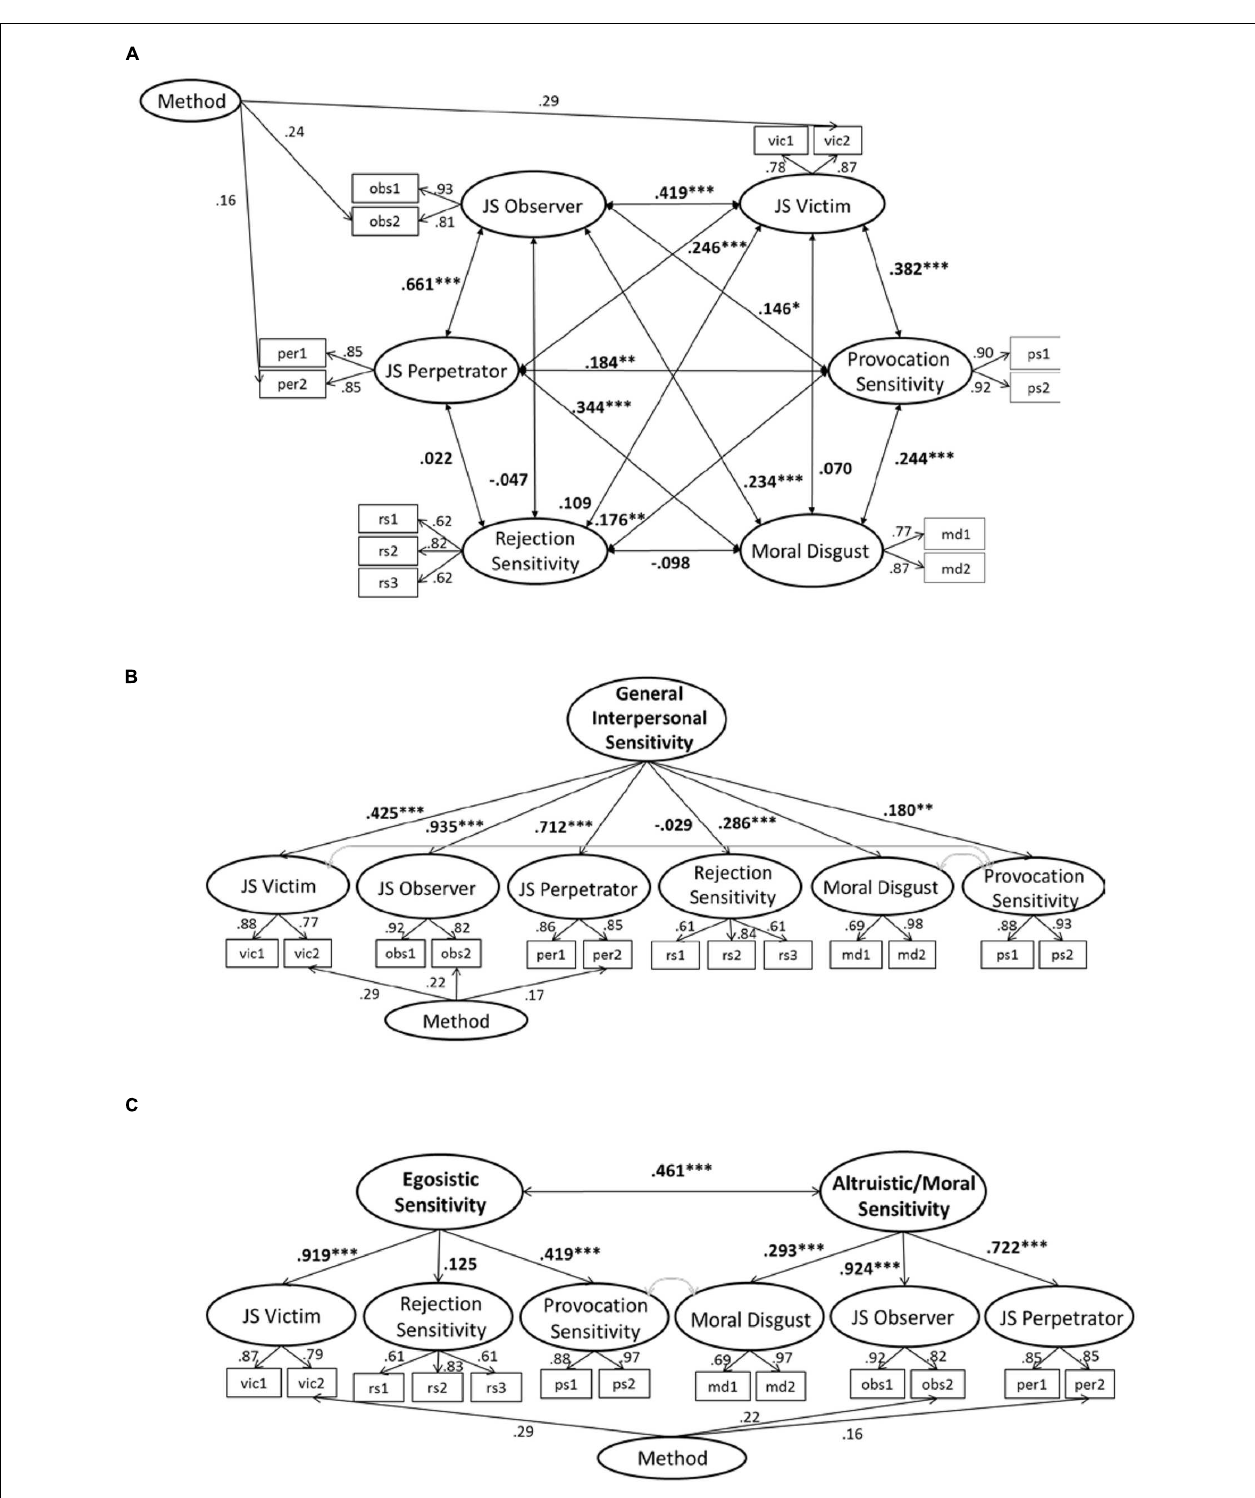
FIGURE 1 | Comparison of three different Confirmatory Factor Analysis (CFA) models. Results of the χ 2 -difference test and comparisons of absolute fit indices indicate that model a with six discrete, but correlated sensitivity factors shows the best fit with the data. (A) CFA model with discrete, interrelated sensitivity factors: χ 2 = 91.985, df = 48, p < 0.001, RMSEA = 0.051, CFI = 0.975, SRMR = 0.030, N = 349. (B) CFA model with a second order factor of general interpersonal sensitivity: χ 2 = 117.677, df = 55, p < 0.001, RMSEA = 0.057, CFI = 0.964, SRMR = 0.054, N = 349. (C) CFA model with two second order factors reflecting primary egoistic and altruistic/moral concerns: χ 2 = 115.042, df = 51, p < 0.001, RMSEA = 0.057, CFI = 0.966, SRMR = 0.048, N = 349.